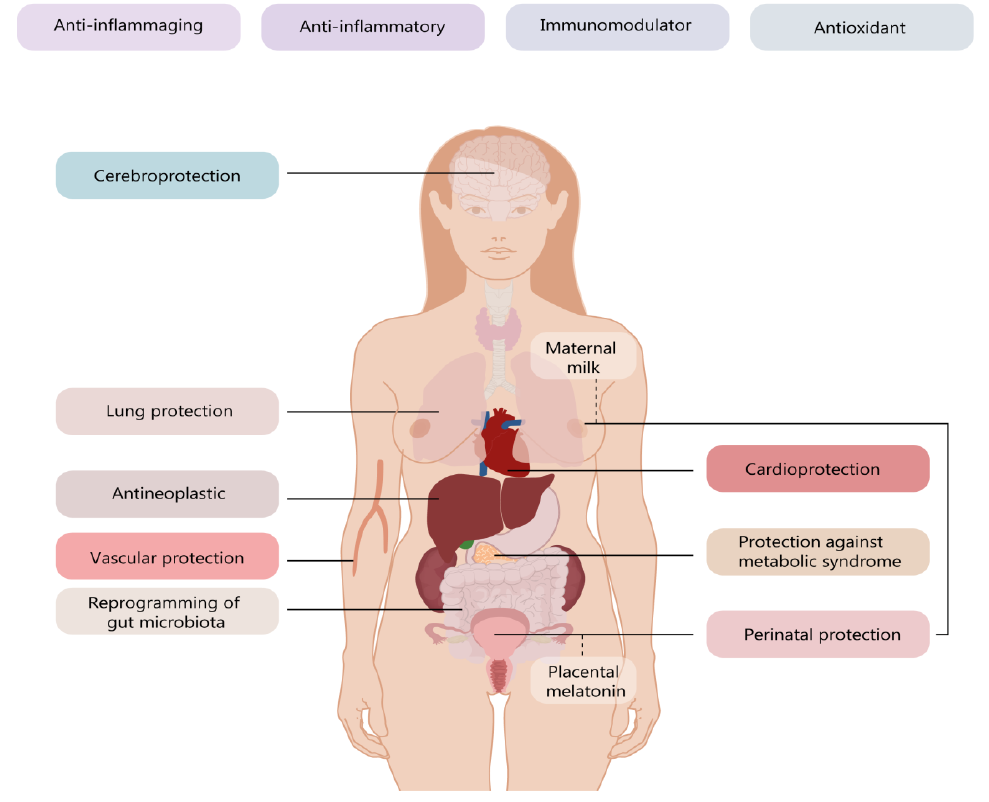
Figure 2. The widespread effects of melatonin at organ and system level.